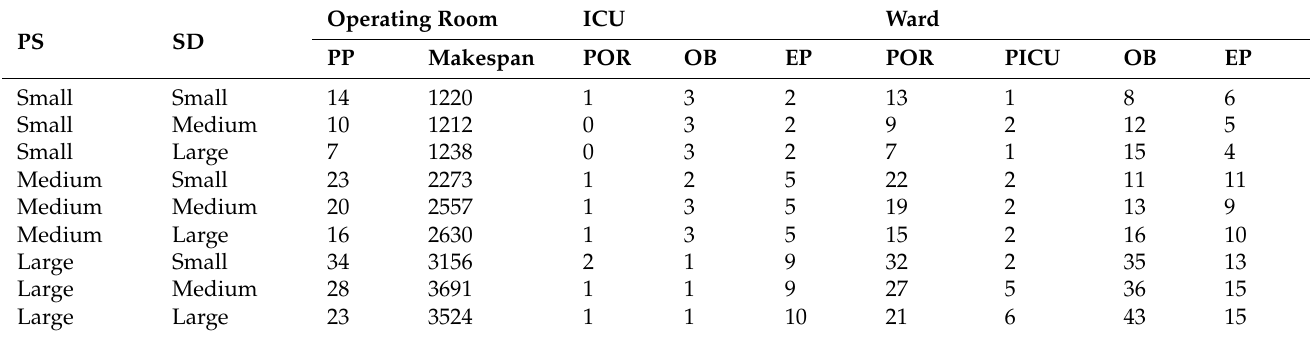
Table 7. Summary results of the lower-level plan when the ward becomes the